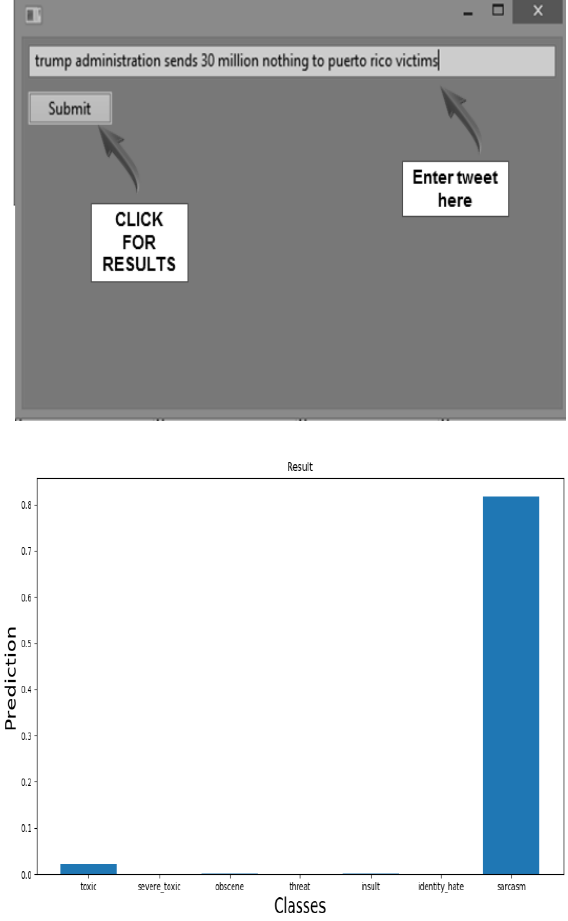
Fig.4. GUI Based shaming category prediction using